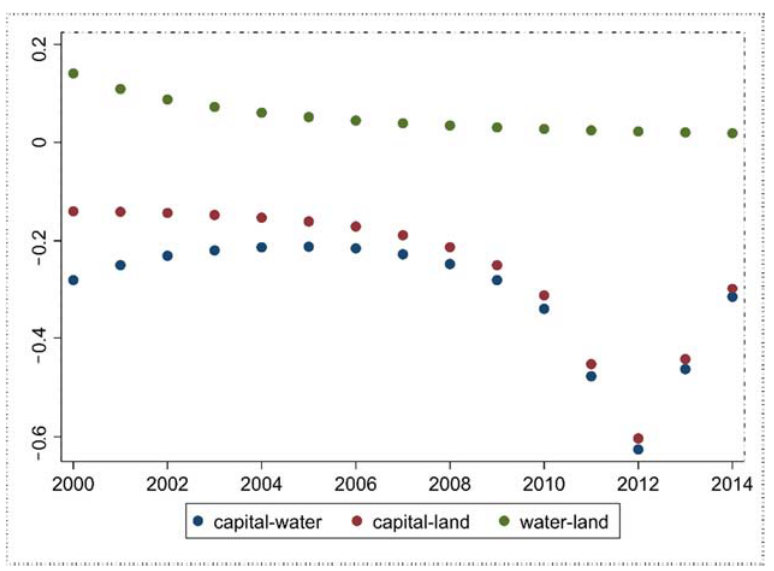
Figure 6. The difference of technical progress in water and land: 2000–2015.